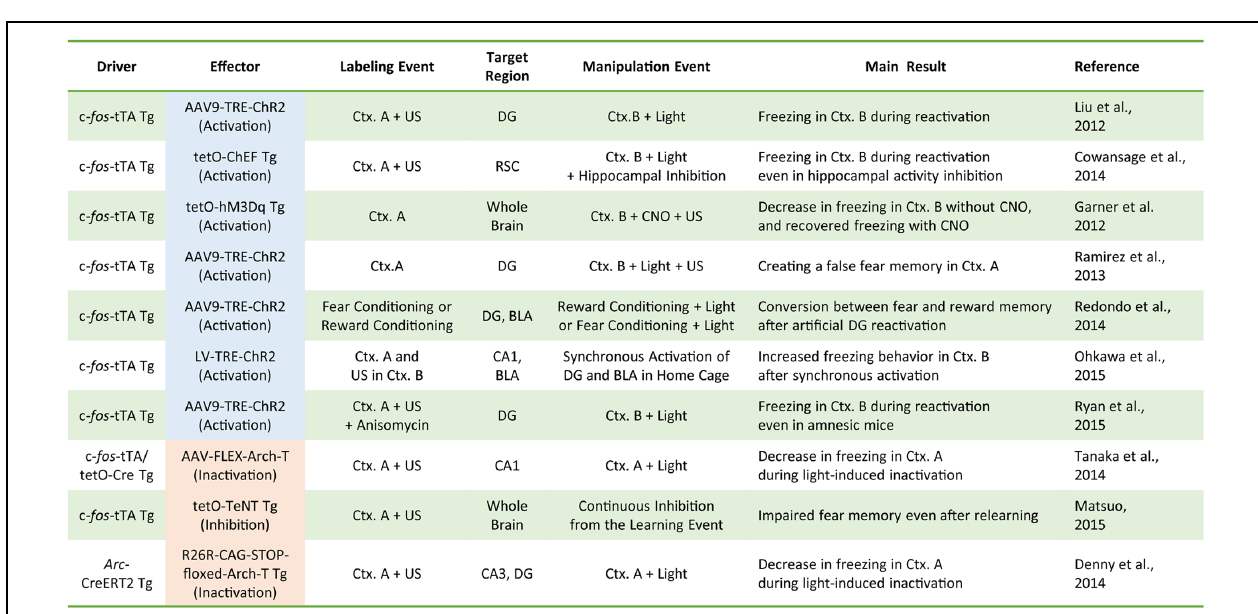
FIGURE 2 | A compendium of the current literature investigating the role of IEG-expressing neurons in memory formation. Driver transgenes promote the expression of the effector proteins that can manipulate neuronal activity. Labeling events induce effector protein expression via the driver transgenes. During activity manipulation events, IEG-expressing neurons are activated or inactivated by applying the trigger (e.g., light or clozapine- N -oxide; CNO). Tg, transgenic animal; AAV, adeno-associated virus; LV, lentivirus; tTA, tetracycline transactivator; tetO, tetracycline operator; TRE, tetracycline response element; ChEF, channelrhodopsin chimeric variant; Ctx, context; US, unconditioned stimulus (e.g., electrical foot shock); FLEX, flip-excision (double floxed system); TeNT, tetanus toxin.